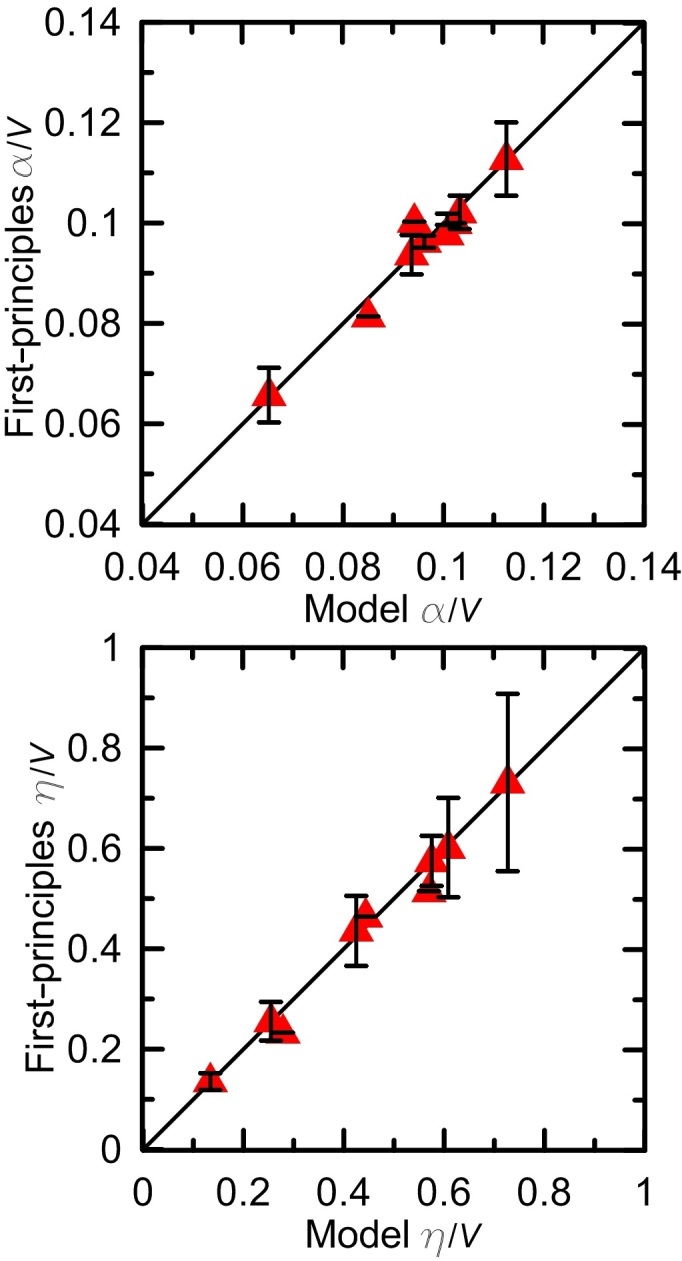
Parameters α/V and η/V.Comparison between parameters (α/V and η/V) of many MgO, Al2O3, and SiO2 phases calculated from DFPT and those estimated by using αi, ηi, and Vi values of coordination polyhedron i.